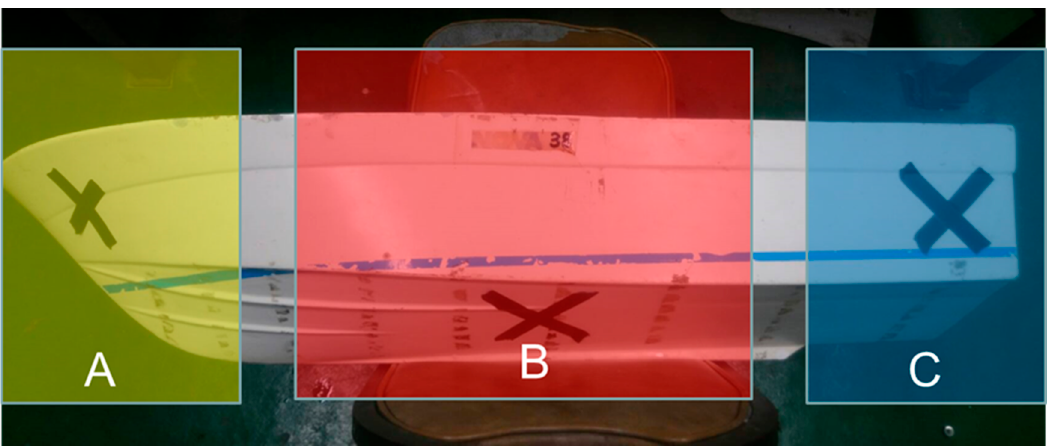
Figure 19. Regions of the proposed ship model.